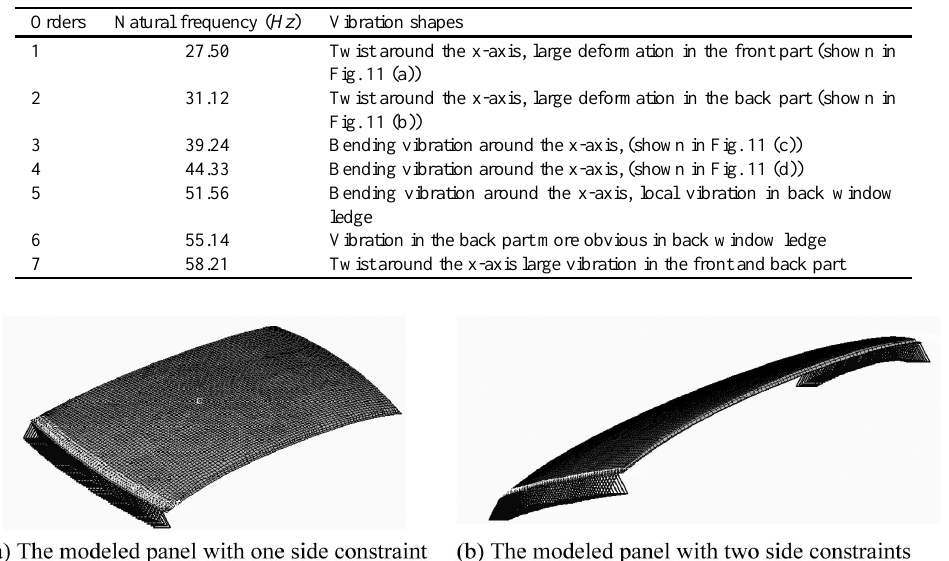
Table 7 The modal testing results of BIW